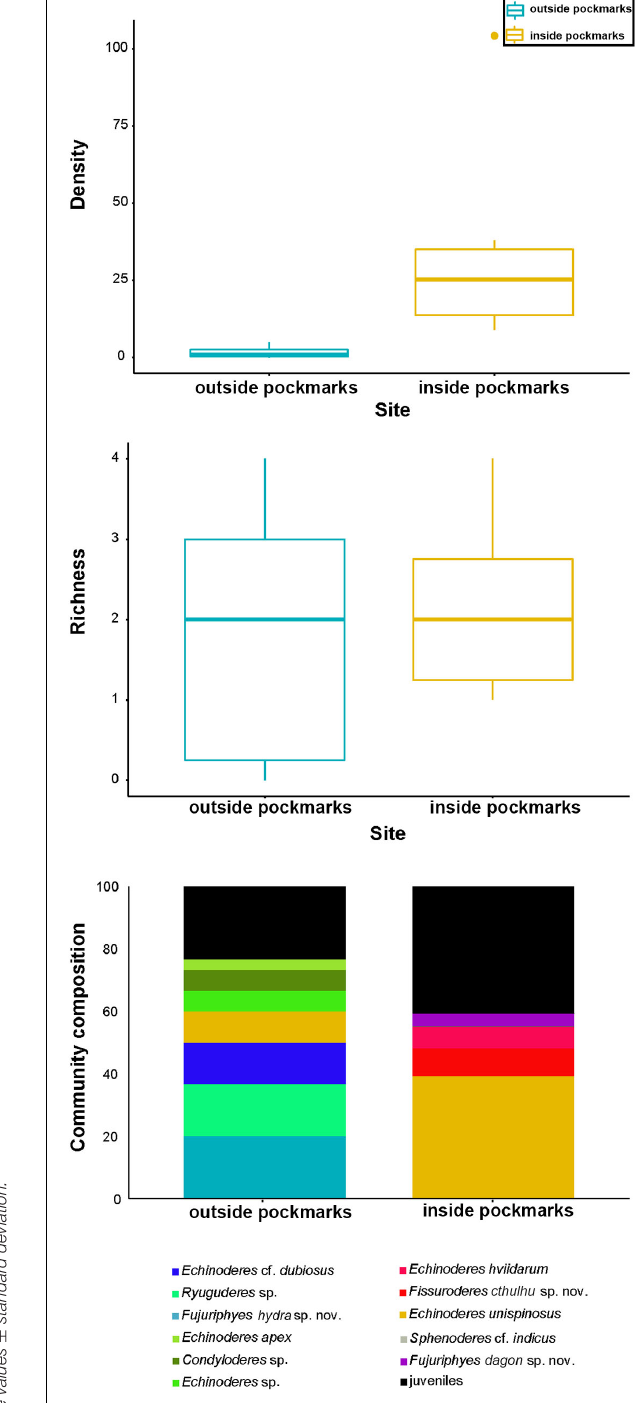
FIGURE 12 | Kinorhynch density, richness, and community composition at the two study habitats, inside pockmark (yellow) and outside pockmark (blue). Boxplots represent the median value (horizontal line within the box), the distributions of 50% of the data (the box), and the highest and lowest values within 95% of the distribution (the whisker). Contribution of each kinorhynch species to the total community is expressed in percentage in relation to the total